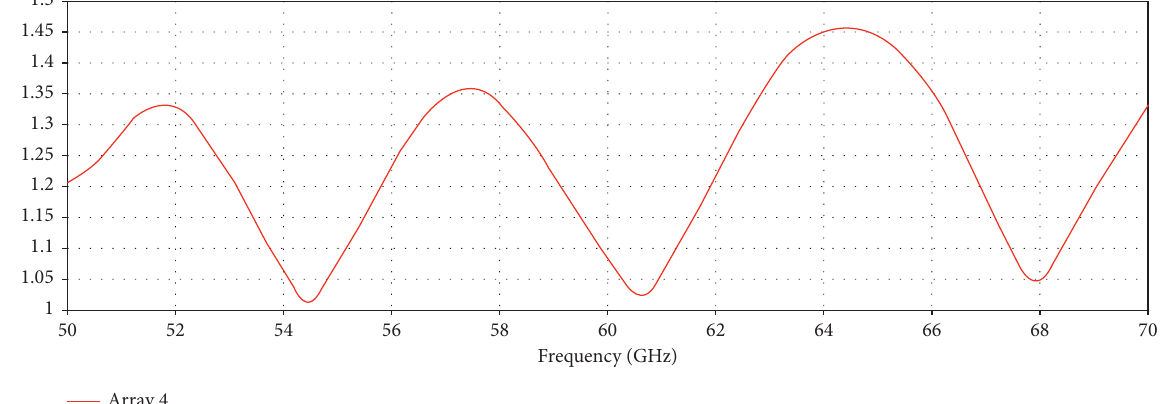
Figure 10: Free-space VSWR of Array 4.